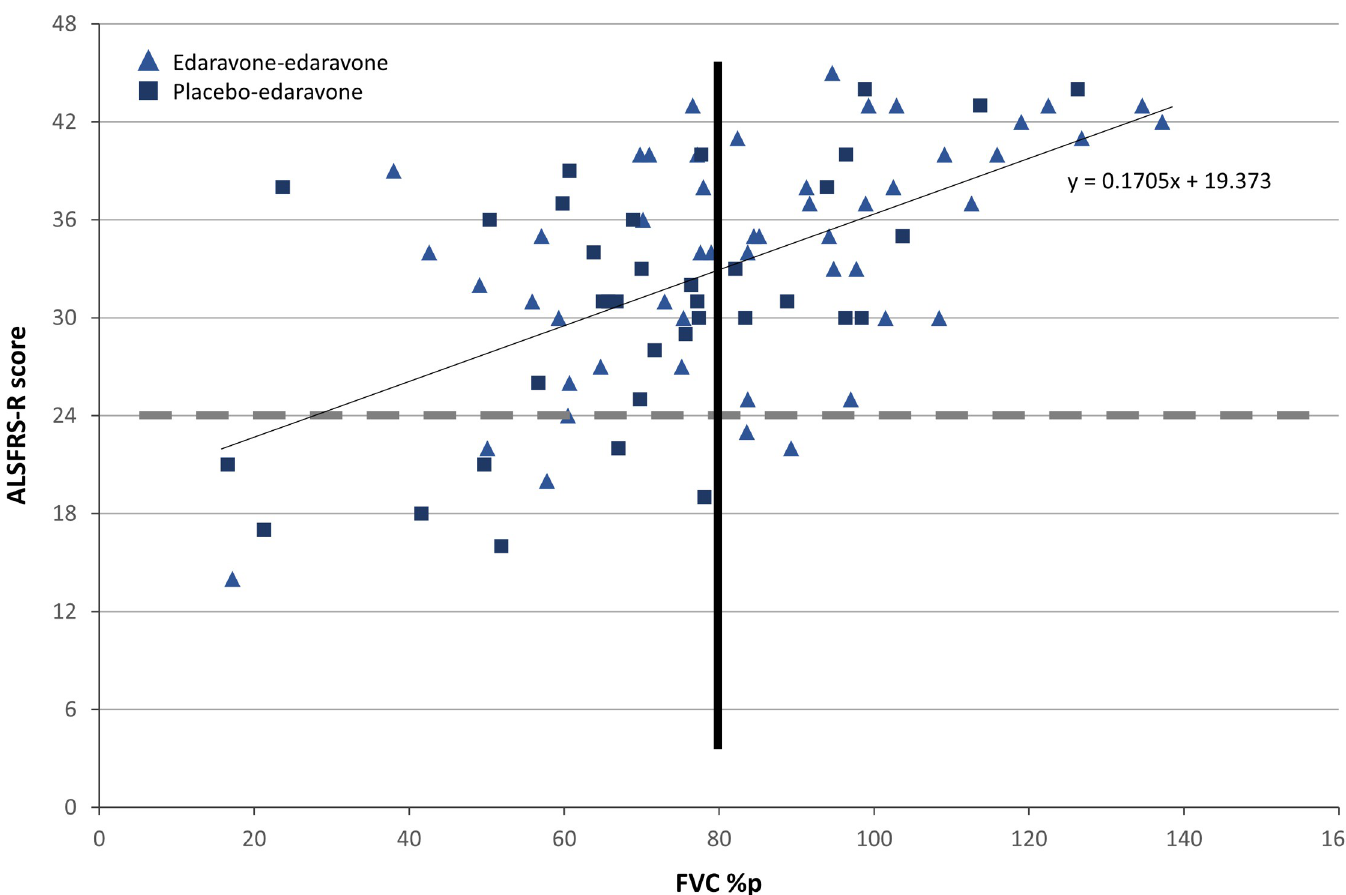
Fig 6. ALSFRS-R score vs FVC at week 48. Graph of ALSFRS-R vs FVC values at week 48. The dashed gray horizontal line delineates an ALSFRS-R score of 24; the black vertical line delineates an FVC value of 80%p. Each triangle represents 1 subject in the edaravone-edaravone group and each square represents one subject in the placebo- edaravone group at week 48. Over a wide range of FVC 48 %p, a large number of ALS subjects participating in the clinical trial maintained an ALSFRS-R total score at or above 24 throughout the clinical trial period. Linear regression line equation is shown on the graph. %p, percent of predicted; ALS, amyotrophic lateral sclerosis; ALSFRS-R, Amyotrophic Lateral Sclerosis Functional Rating Scale-Revised; FVC, forced vital capacity.